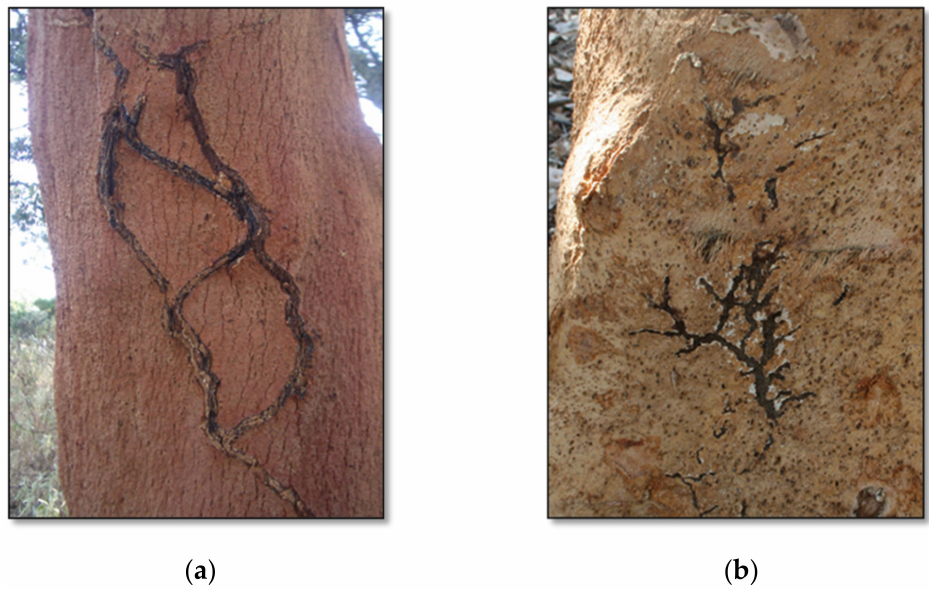
Figure 1. Lesions in Q. suber trunk performed by boring insects. ( a ) “cork shingles” by C. undatus , in which three interceptions are visible; ( b ) “chicken feet” by R. grassei , with one interception